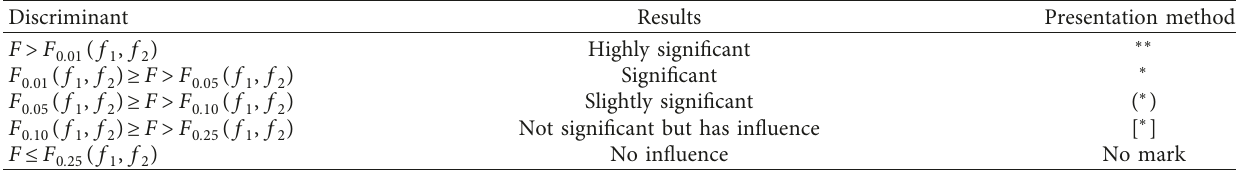
Table 3: The results of the F -test and the methods of presentation. Discriminant Results Presentation